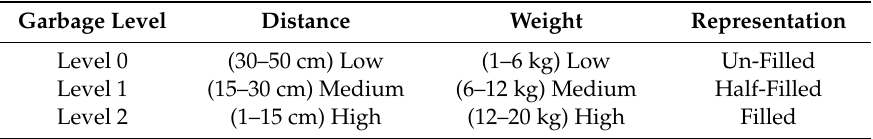
Table 3. Representations of sensor